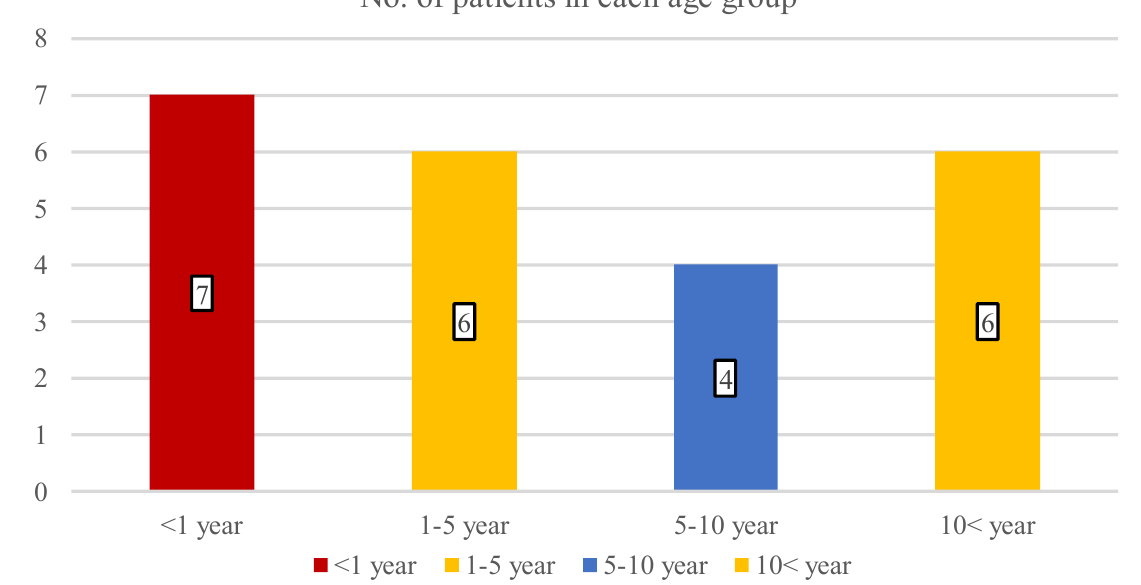
Figure 2. The number of children in four different age groups. With the analysis of the burn etiologies, we found that all of the traumas were acci- dental and the most common mechanism was scalding (56.5%), followed by flame (30.4%), contact (8.7%), and chemical injuries (4.3%) (Figure 3). During infancy, the incidence of scalding was 85.7% (6 out of 7 patients), while in teenagers, the risk of flame-caused burns increased to 66.6%.